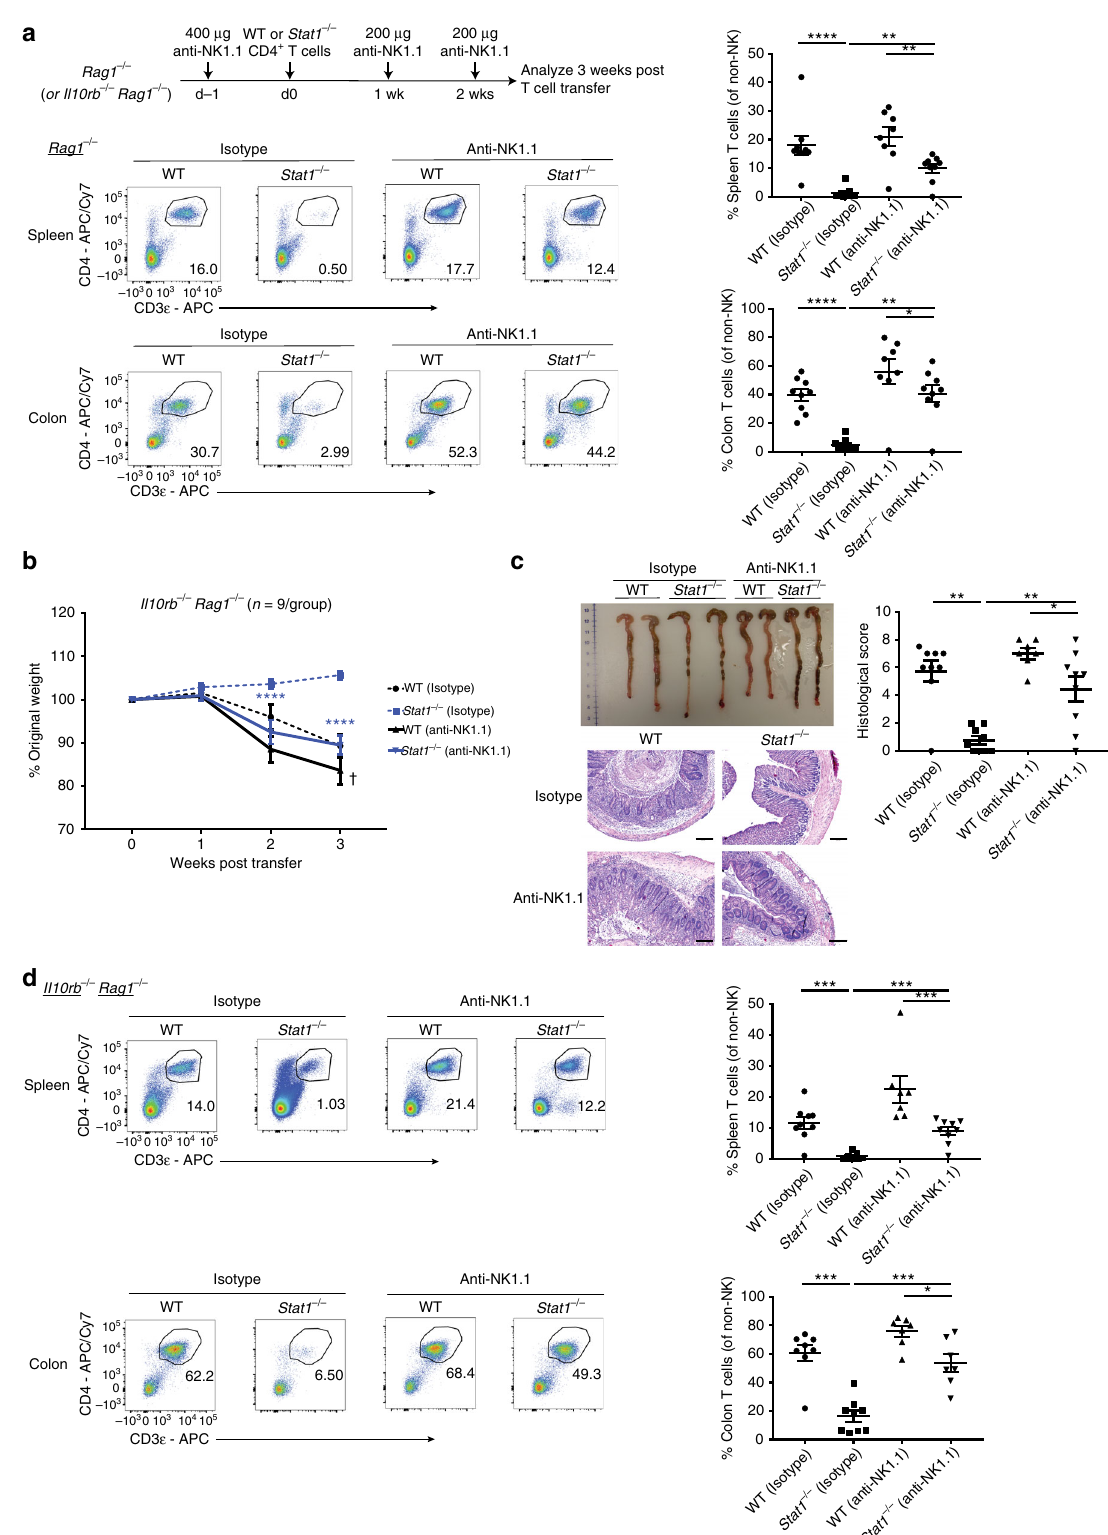
The upstream signal(s) that activates the STAT1-NLRC5-MHC class I axis in T cells in vivo has not been fully elucidated. In vitro, Nlrc5 expression in T cells is primarily triggered by autocrine IFN γ signaling 31 . In vivo, type I IFN has been reported to protect antiviral T cells and NK cells from NK mediated elimination